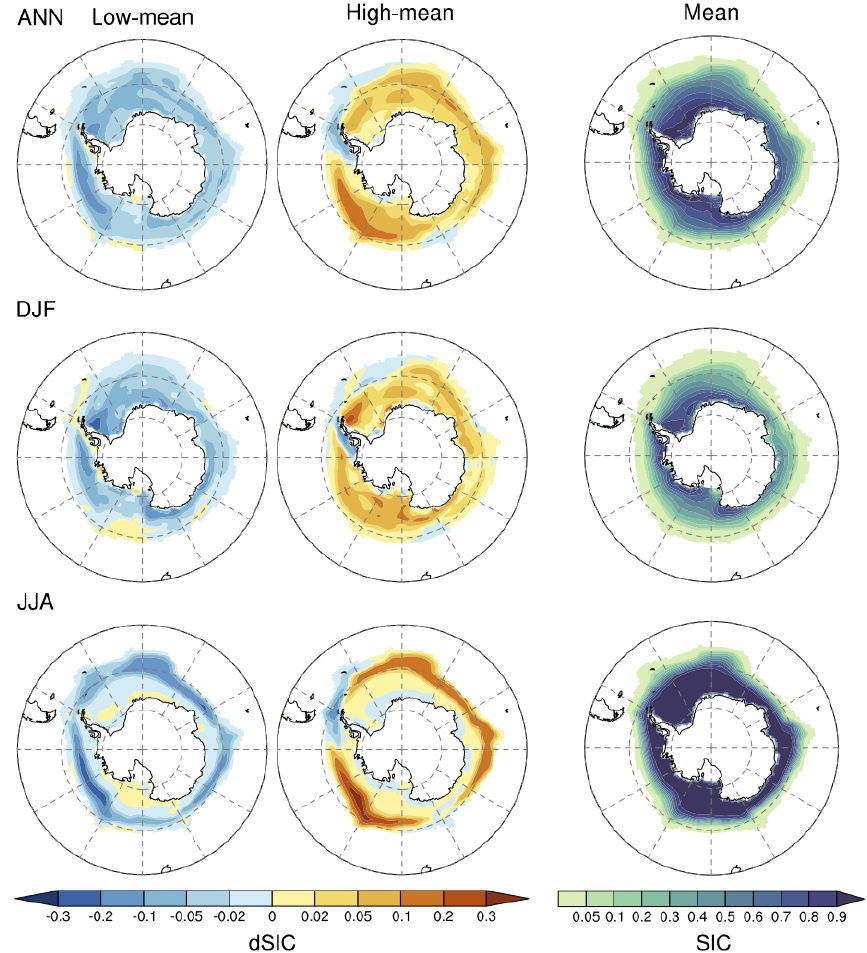
Figure 1. The anomalies of the two SIC composites (low and high) with respect to the annual and seasonal mean SIC (mean in the right-most